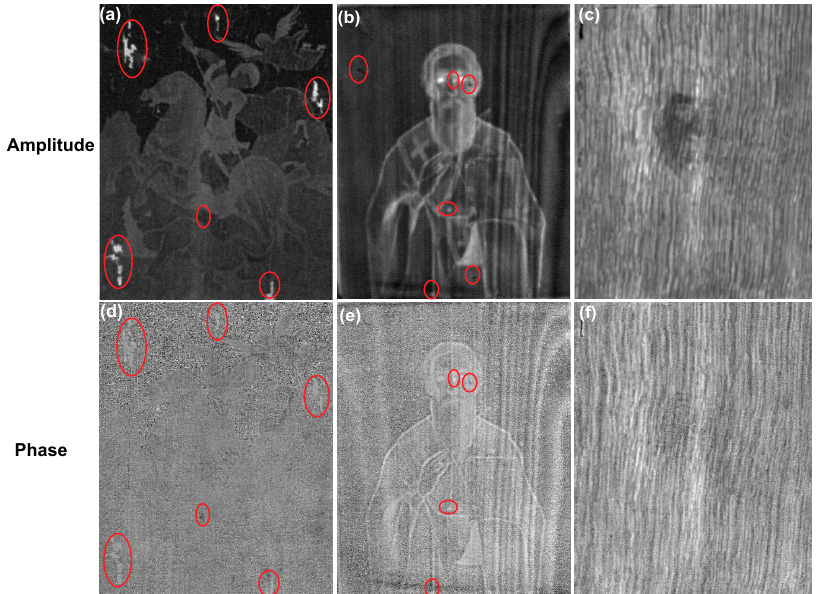
Figure 7. LIT amplitude and phase images of each painting for the B-MWIR_F setup. Some of the surface defects are more pronounced in the amplitude images ( a , b ) when compared to the phase images ( d , e ). Several defect areas are circled in red. Phase images ( f ) are influenced less by the upper paint layer than amplitude images ( c